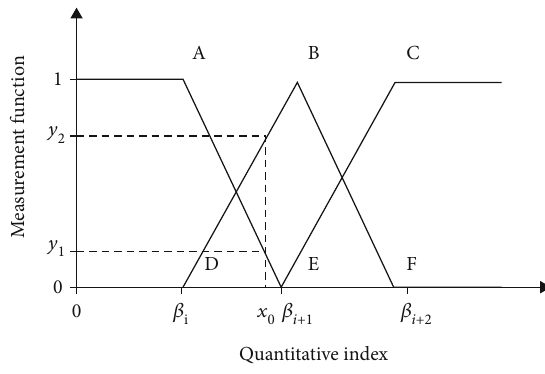
Figure 2: Unascertained measurement function of one certain quantitative